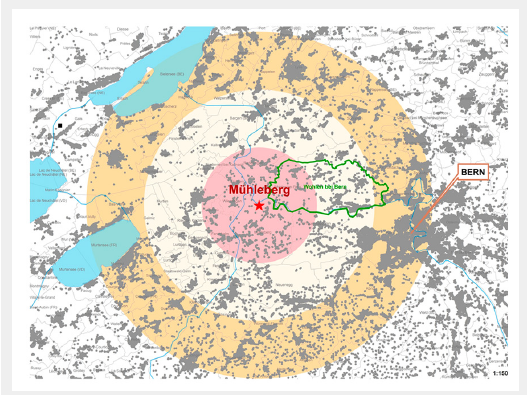
Map showing consecutive 5-km zones (<5 km, 5–10 km, 10–15 km) around the Mühleberg nuclear power plant, residential homes of children from the general population (grey points), community boundaries (grey faint lines, community “Wohlen bei Bern” with green boundaries as an illustrative example).